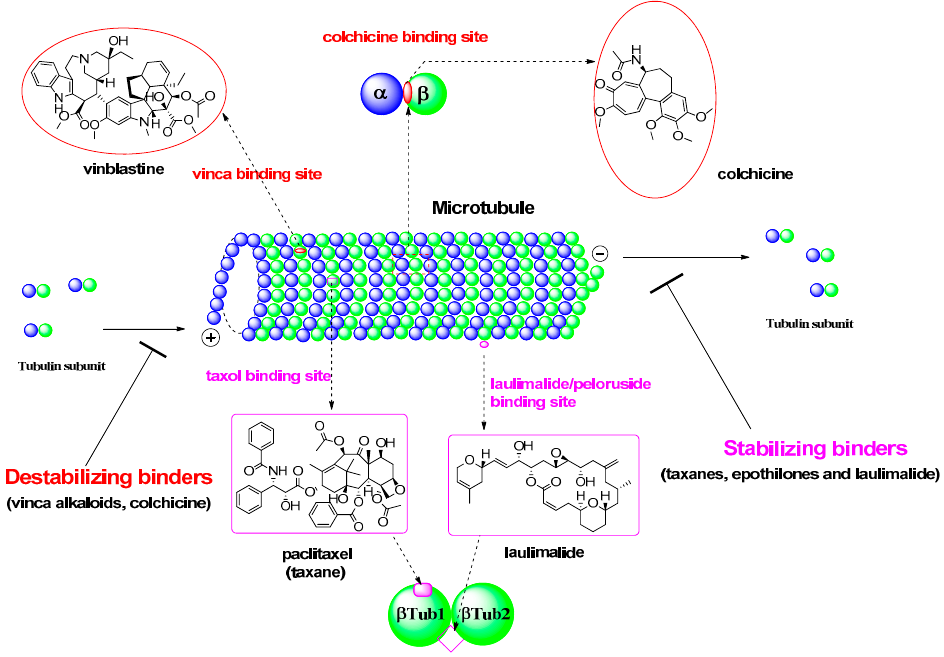
Figure 2. Tubulin binding sites and representative natural products of microtubule-targeted drugs.